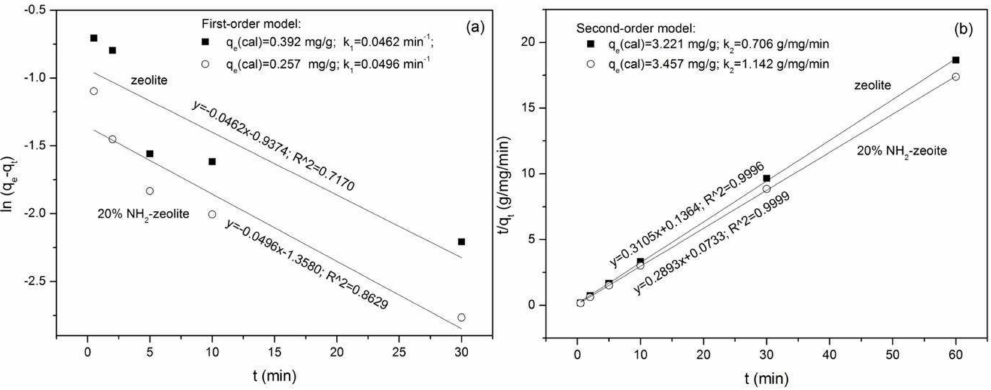
Figure 13. Plots of pseudo-first-order ( a ) and pseudo-second-order kinetic models ( b ) for adsorption of naphthalene onto zeolite and the 20% amino functionalized zeolite